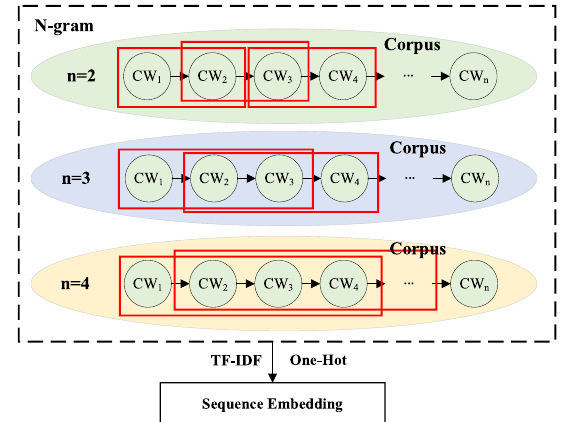
Fig. 4 The flow of GloVe